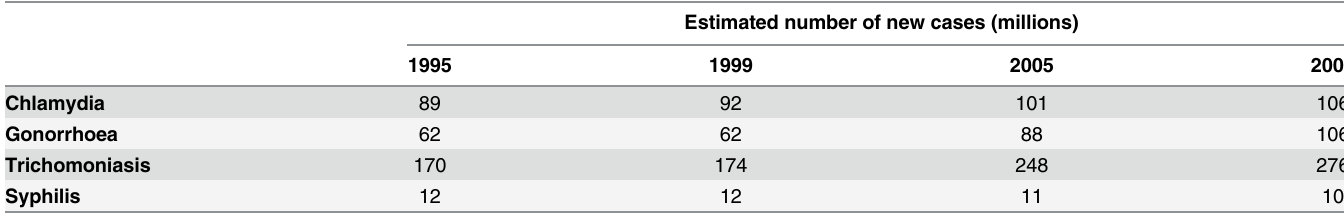
Table 1. WHO estimates of new cases of chlamydia, gonorrhoea, trichomoniasis, and syphilis among adults for 1995, 1999, 2005, and 2008 using various methods [4 –